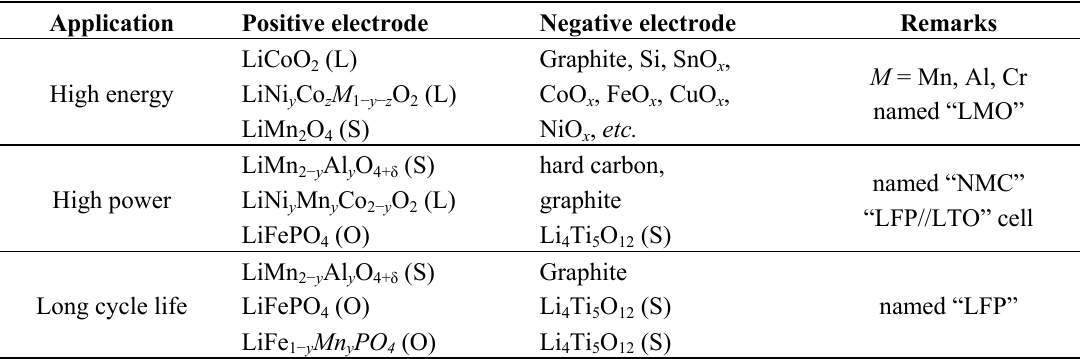
Table 3. Configuration of the three types of Li-ion cells related to their application.